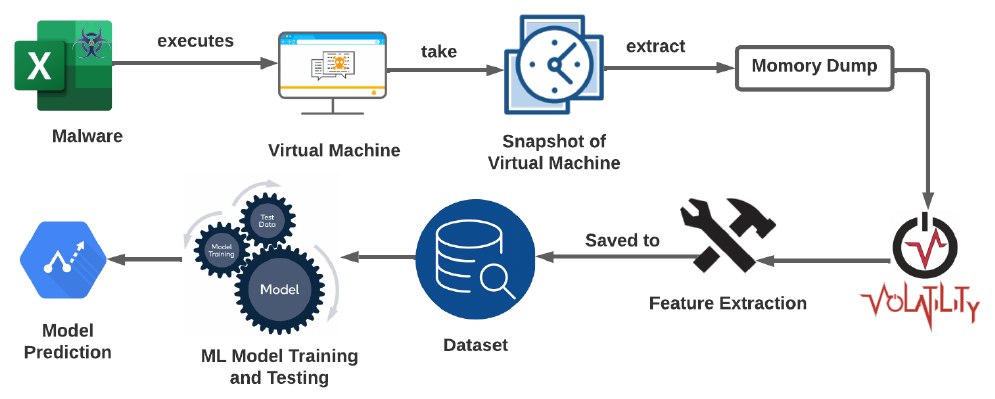
Figure 5. Architecture Of proposed system.